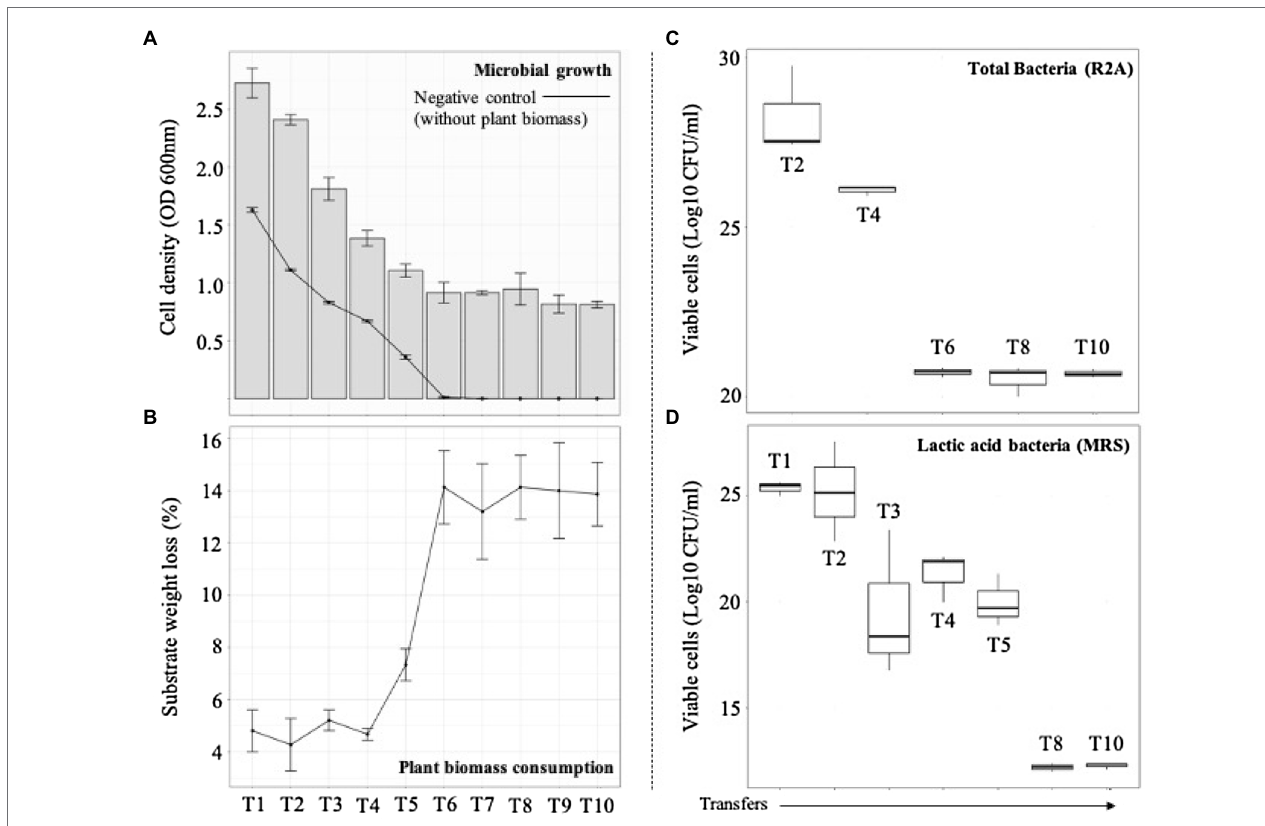
FIGURE 2 | Microbial growth and plant biomass (PB) degradation values after each sequential growth-dilution steps (T1–T10). (A) Bars show cell density [optical density (OD) at 600 nm] and the line shows cell density in the control medium containing no PB. (B) Average substrate weight loss (percent). Error bars represent SDs from three biological replicates. Viable cells (Log10 CFU/ml) of (C) total and (D) acid lactic bacteria quantified in agar R2A and MRS,